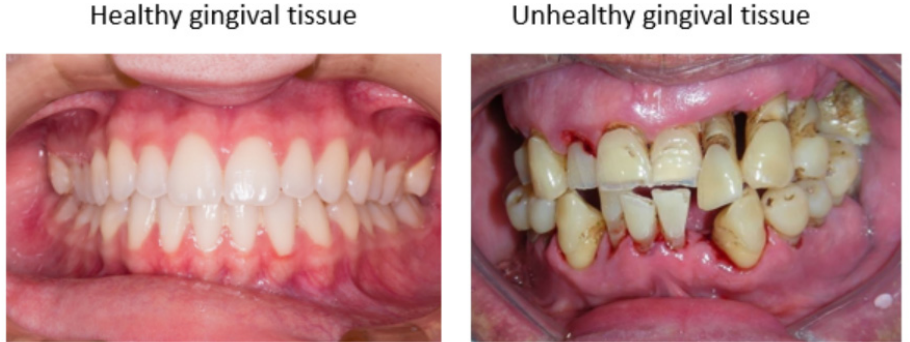
Figure 4. Comparison of healthy and unhealthy gingival tissue. The healthy gingiva is pink in color, while unhealthy gingiva is darker red, and may present bleeding. (Photos from Pixabay.com and Wikipedia.org.)